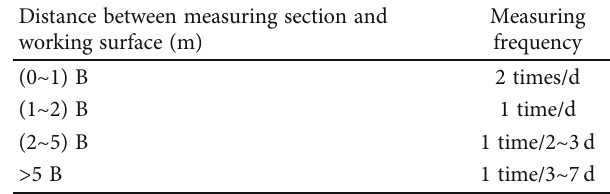
Table 4: Measurement frequency of dome subsidence and peripheral convergence displacement (according to the distance from the excavation